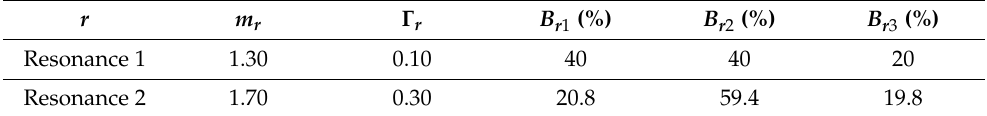
Table 4. BW pole